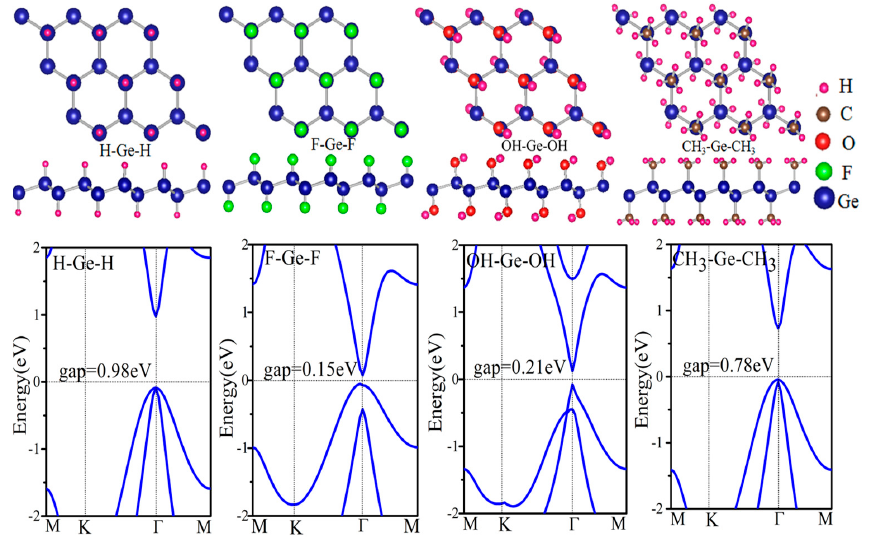
Figure 2. Relaxed geometric structures and the band structures of germanene functionalized with H, F, OH and CH 3 .